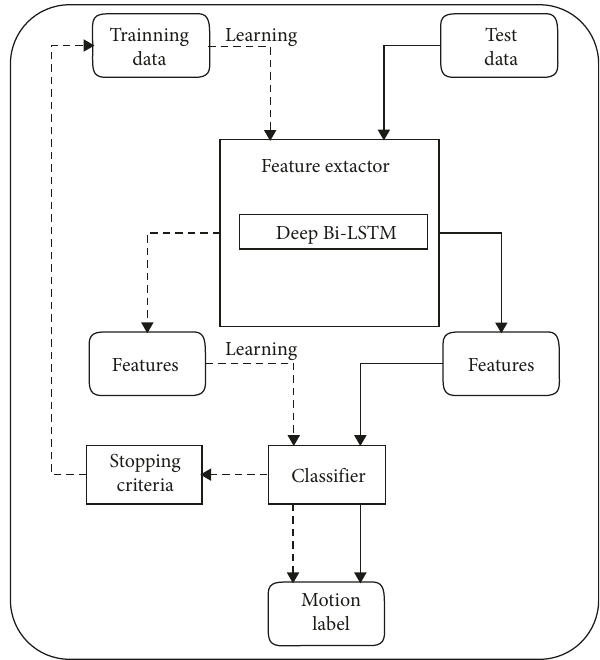
Figure 5: Feature extraction for transport state